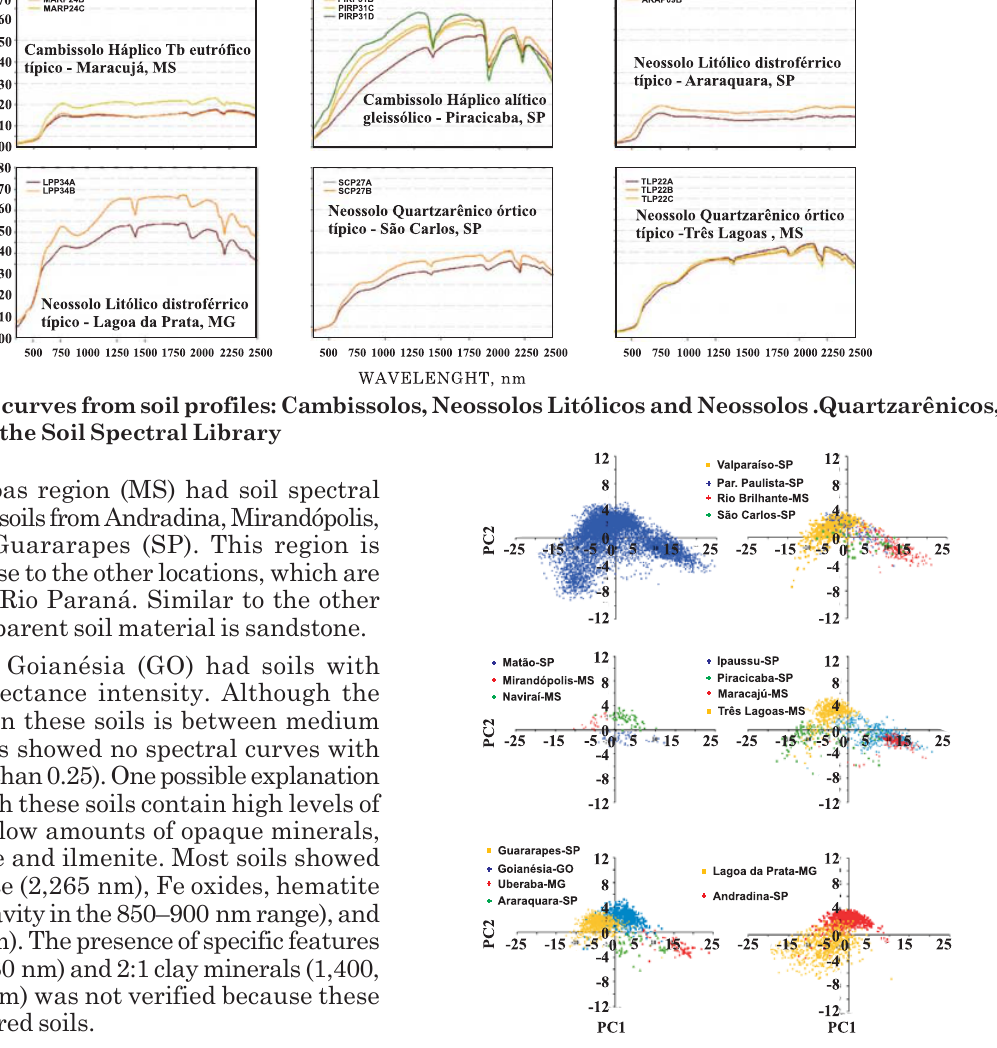
Figure 5. Principal component analysis from soil spectral data in the different regions evaluated, data graph and region by region